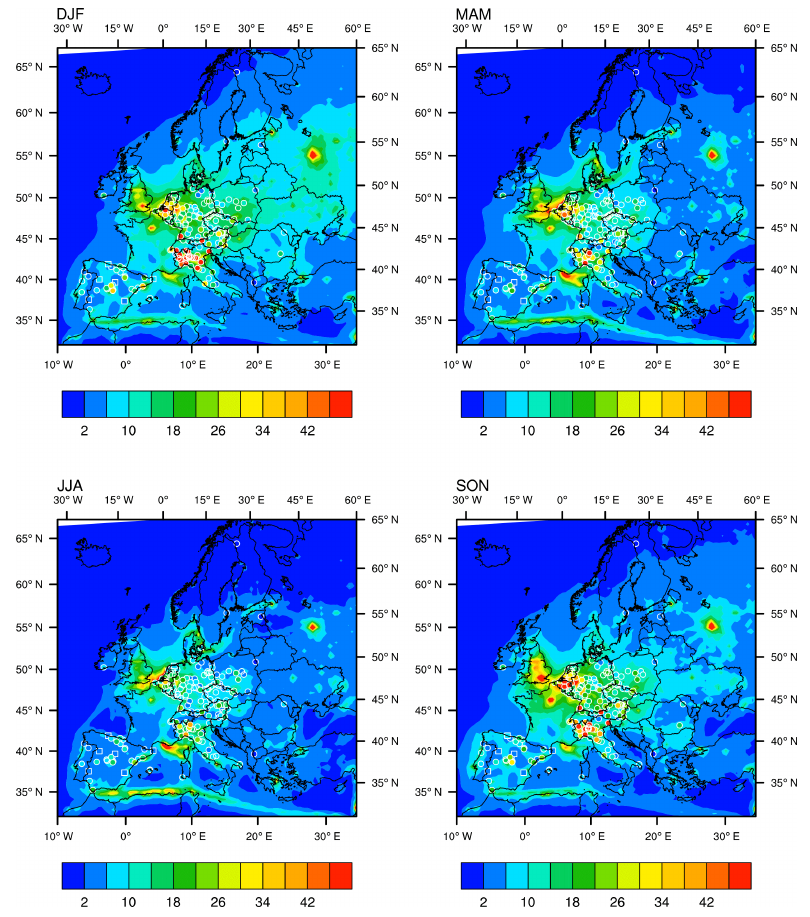
Figure 11. Seasonal average values of surface NO x in µgm − 3 . Contours are model output from the MOZART simulation. Filled dots represent hourly measurements at AirBase rural background stations; filled squares represent measurements at EMEP